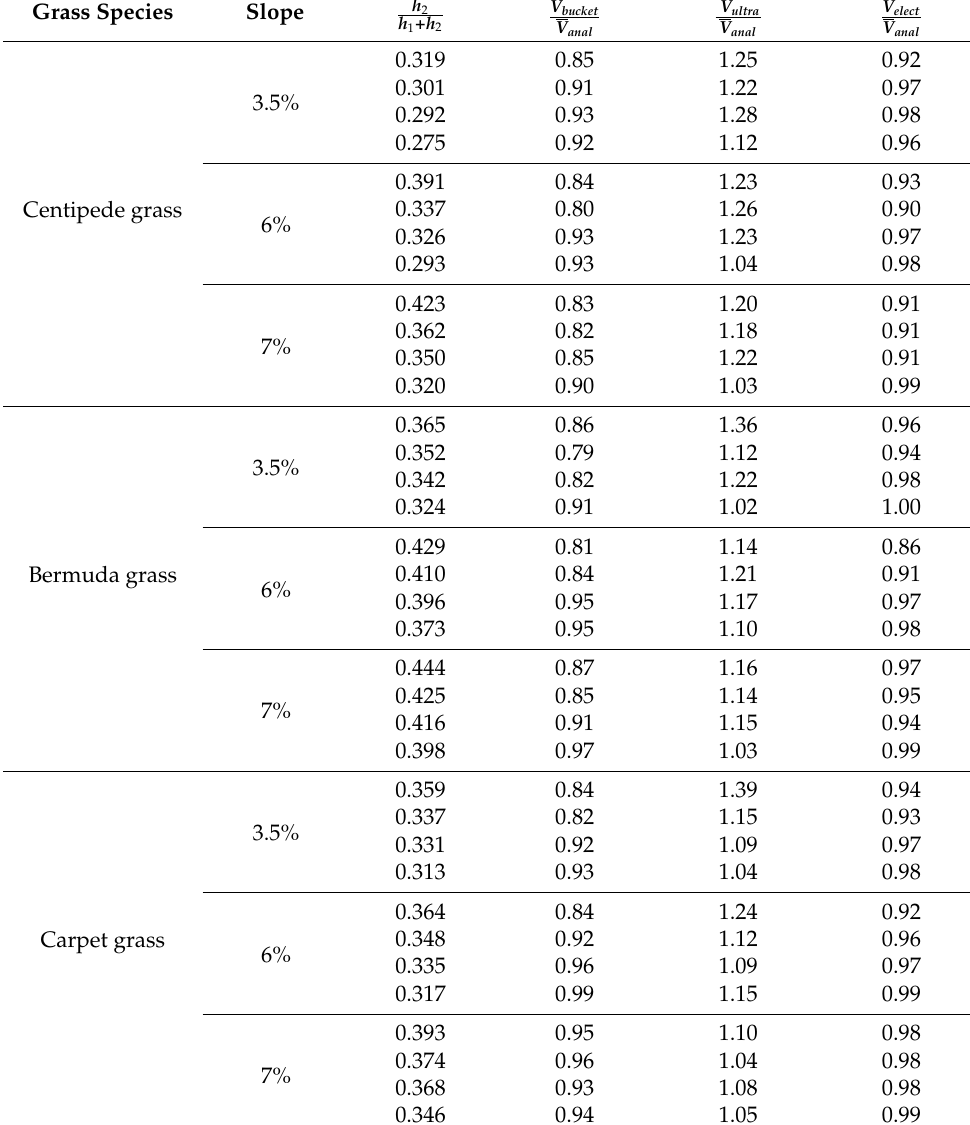
Table 3. Velocity ratios of measured values to the analytical